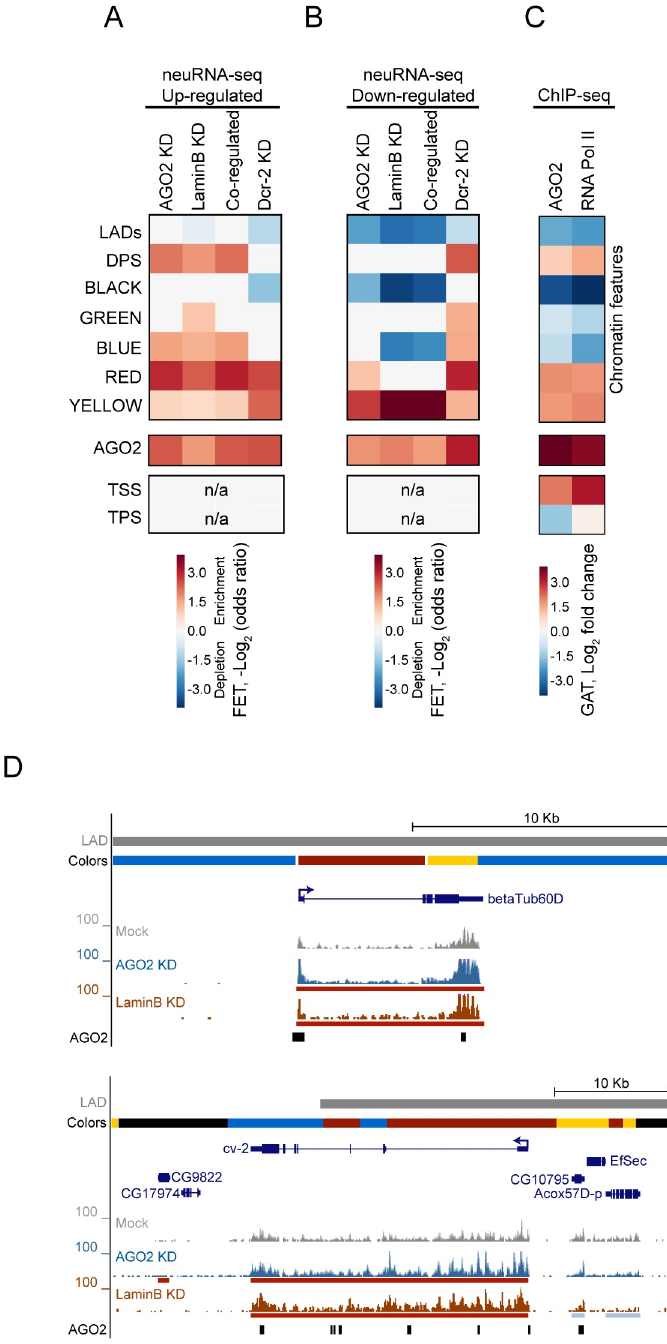
Fig 3. AGO2 and LaminB attenuate transcription in active chromatin and additional sites across the genome. A) Heatmap showing enrichment and depletion of neuRNA-seq up-regulated genes in AGO2-, LaminB, both- or Dcr- 2-depleted cells across different chromatin features such as chromatin domains (LADs and DPSs), chromatin colors, transcription start sites (TSS), and transcription polyadenylation site (TPS). The color scale indicates the log 2 odds ratio of the Fisher’s exact tests, where negative (blue) indicates depletion and positive (red) indicates enrichment. B) Heatmap showing enrichment and depletion of neuRNA-seq down-regulated genes in AGO2-, LaminB, both- or Dcr- 2-depleted cells with respect to chromatin features. C) Heatmap showing enrichment and depletion of AGO2 and Pol II ChIP-seq peaks with respect to chromatin features. Colormap represents the log 2 fold change as reported by the Genomic Association Test (GAT). D) Representative screenshot of co-up-regulated genes in AGO2 KD and